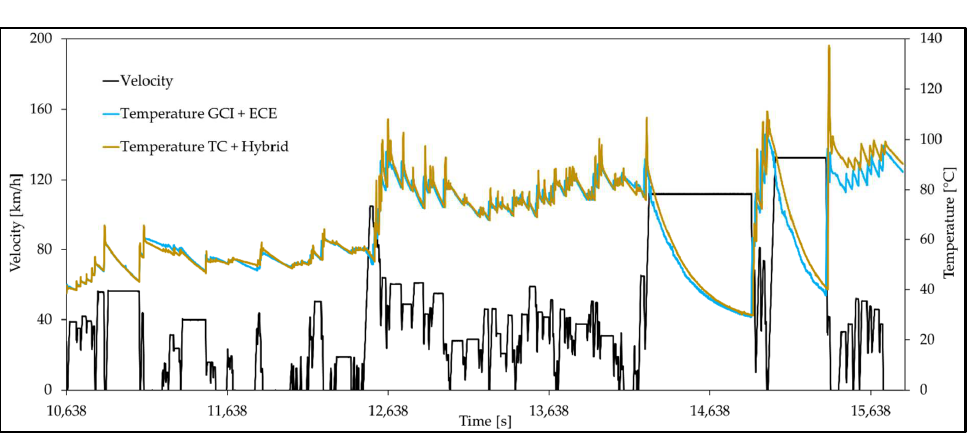
Figure 15. Temperatures of the HMC pairing compared to the GCI pairing during WLTP Brake Cycle Trip 10. The colored background areas represent the GTR temperature corridors valid at the time the investigations were conducted.